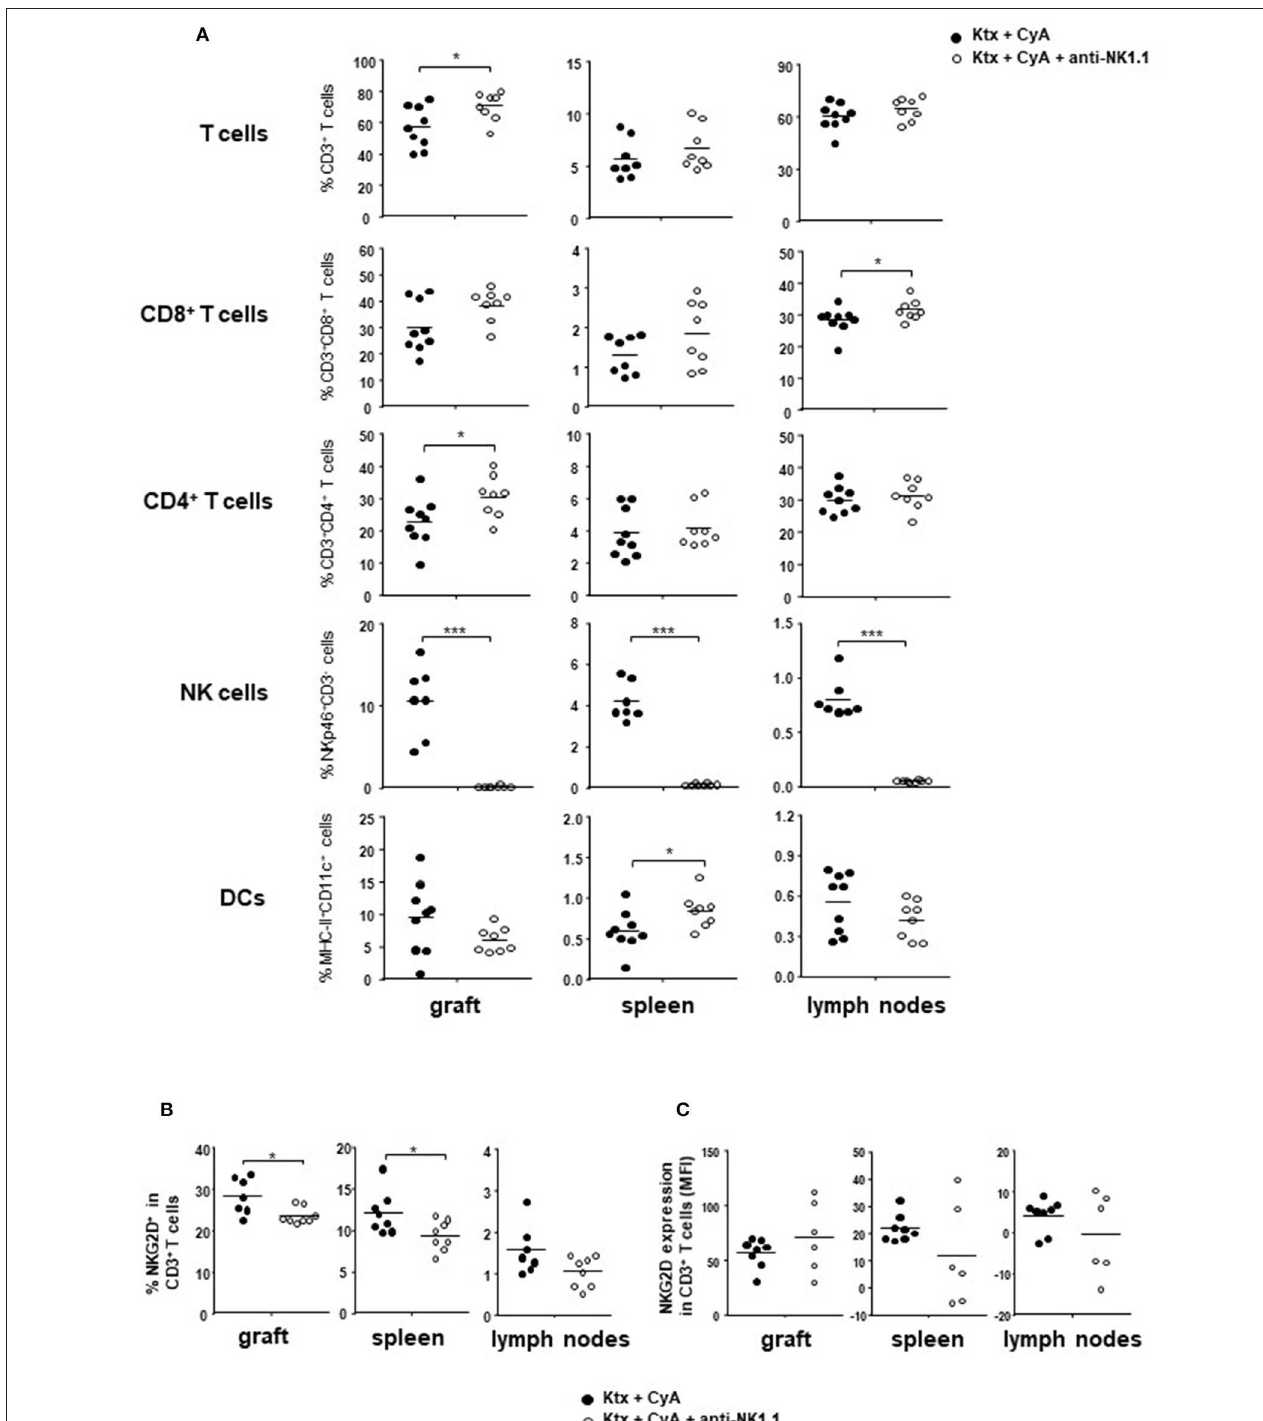
FIGURE 4 | Short-course depletion of NK cells in combination with CyA increases intragraft CD4 + T cells. (A) NK depletion at POD-2 and POD + 2 results in increased intragraft T cell frequencies at POD7, whereas NK cells were efficiently depleted in the kidney, spleen and lymph nodes. (B) Frequencies of NKG2D + CD3 + T cells are significantly reduced in graft and spleen following NK cell depletion, whereas (C) NKG2D is not downregulated on T cells as reflected by mean fluorescence intensity (MFI). Data are presented as mean of n = 7–8 animals/group. Cells were pre-gated on live CD45 + events. Statistically significant differences between naïve and CyA-treated animals were tested with the Mann-Whitney U -test; * p < 0.05, ** p < 0.01, *** p < 0.001.